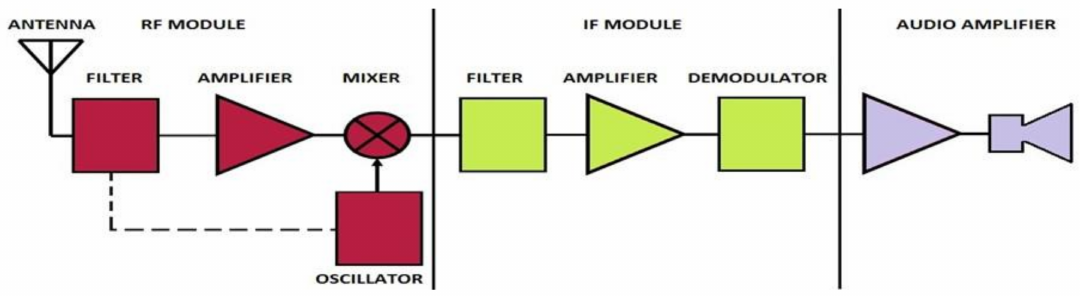
Figure 2. Block scheme of a typical radio